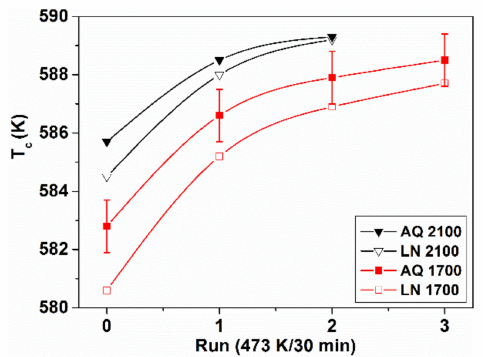
Figure 20. Curie temperature T Cam of FeSi 2 B 15 samples during subsequent measuring runs between which the sample was heat treated at 473 K. Adopted from [97], with permission from Springer Nature, 2004.